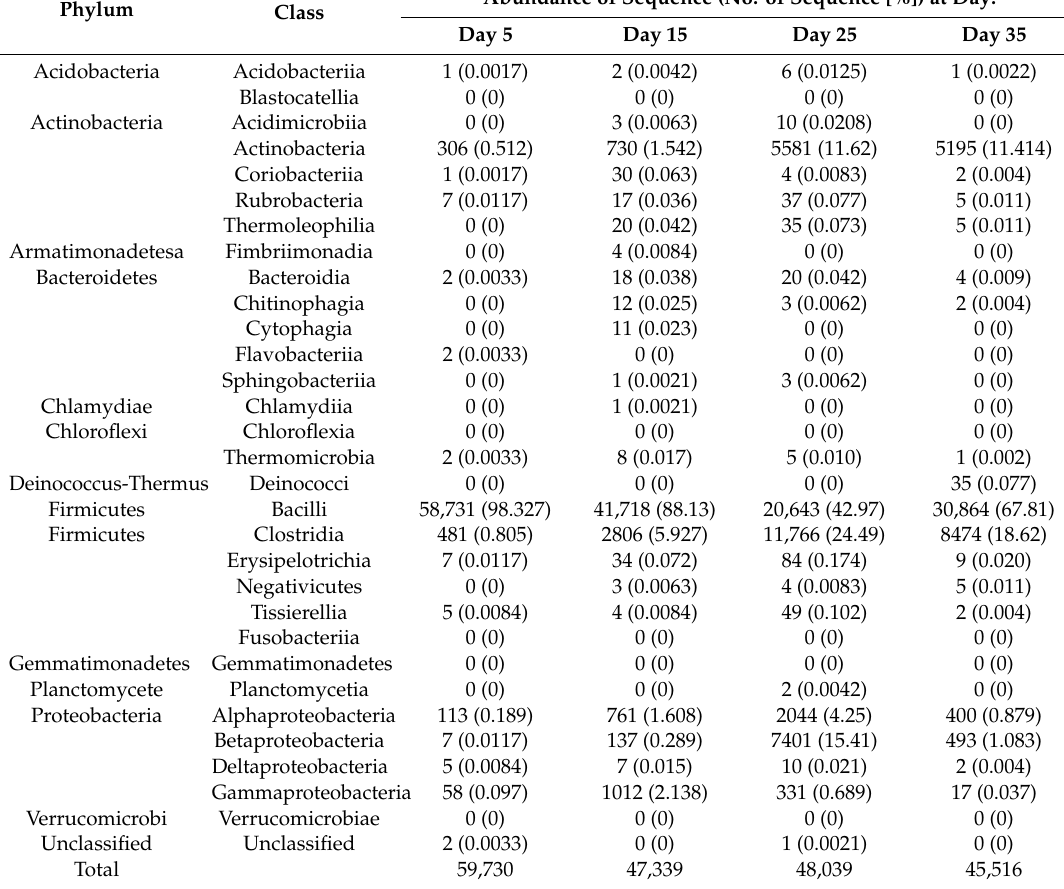
Table 3. Abundance of bacterial 16S rDNA sequences ( n = 200,624) identified from the ileum microbiota of Cobb 500 broiler